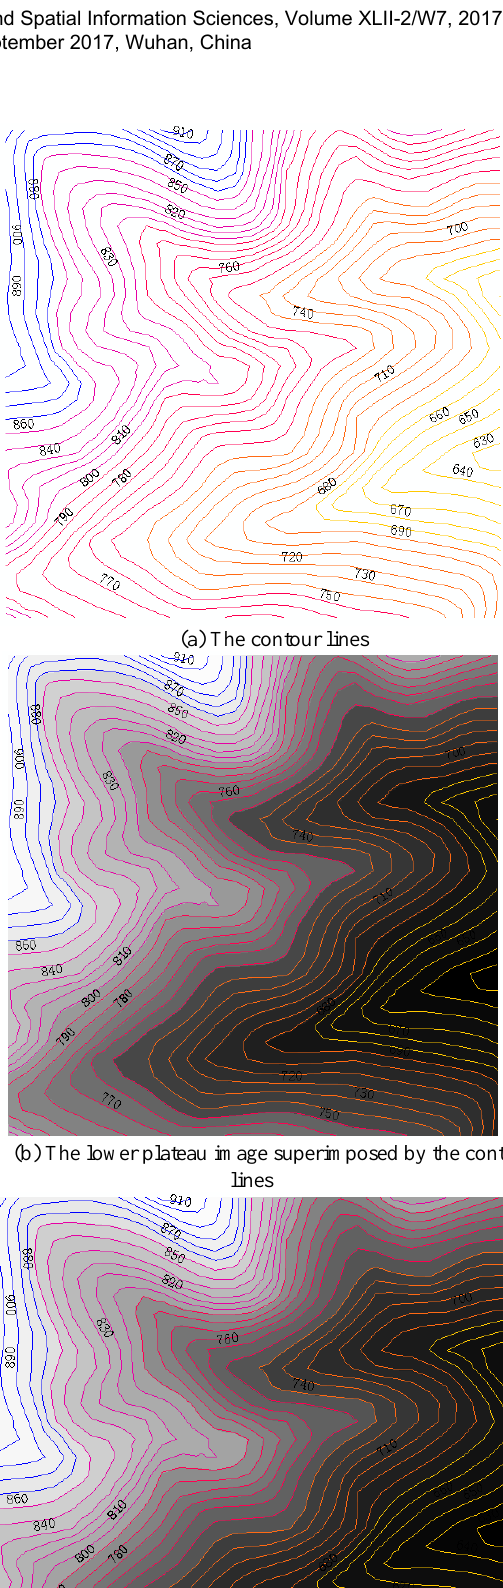
(c) The upper plateau image superimposed by the contour